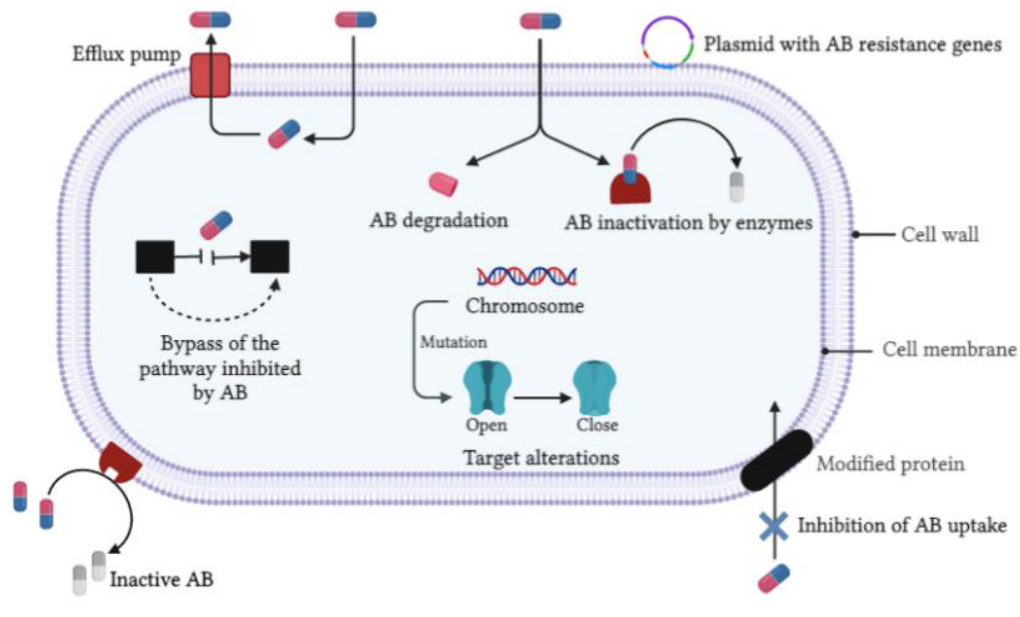
Figure 1. Antibiotic resistance strategies in microorganisms. Mechanisms by which bacteria (and fungi) can resist antimicrobial molecules include: (i) target alterations and modifications through genetic mutations or post-translational modifications, (ii) increased active efflux of antibiotic out of the cell through efflux pumps, a type of membrane transporter located within the microbial membrane or wall, (iii) inactivation, destruction or degradation of the antibiotic through hydrolysis or modification by different enzymes (e.g., extended-spectrum β-lactamases) that can add specific chemical moieties, such as phosphoryl groups, (iv) decreased influx of antibiotic into the bacteria, e.g., through charges in the structure of the cell wall, (v) reduced permeability of the membrane that surrounds the bacterial cell. Created with BioRender.com (accessed on 1 March 2022).